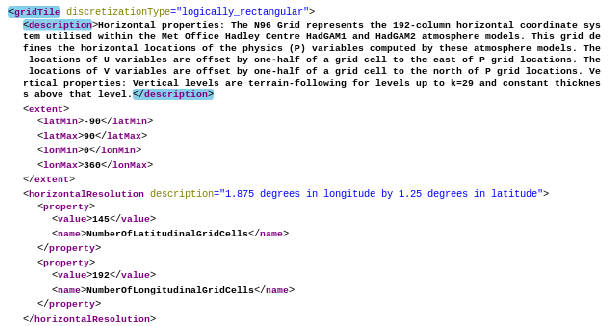
Fig. 4. The primary representation of CIM content is stored and exchanged in XML. This snippet of grid XML underlies some of the material shown in Fig.